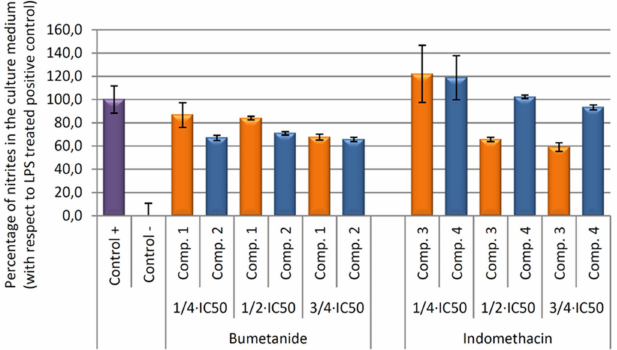
Figure 8. E ff ect of compounds 1 , 2 , 3 , and 4 on the release of nitrites assay in RAW 264.7 macrophage murine cells. After activation of the inflammatory process by incubation with LPS for 24 h, the compounds were incubated for 24 h at concentrations de 3 / 4 × IC 50 , 1 / 2 × IC 50 , 1 / 4 × IC 50 . The data represent the mean ± S.D. of at least two independent experiments performed in triplicate.